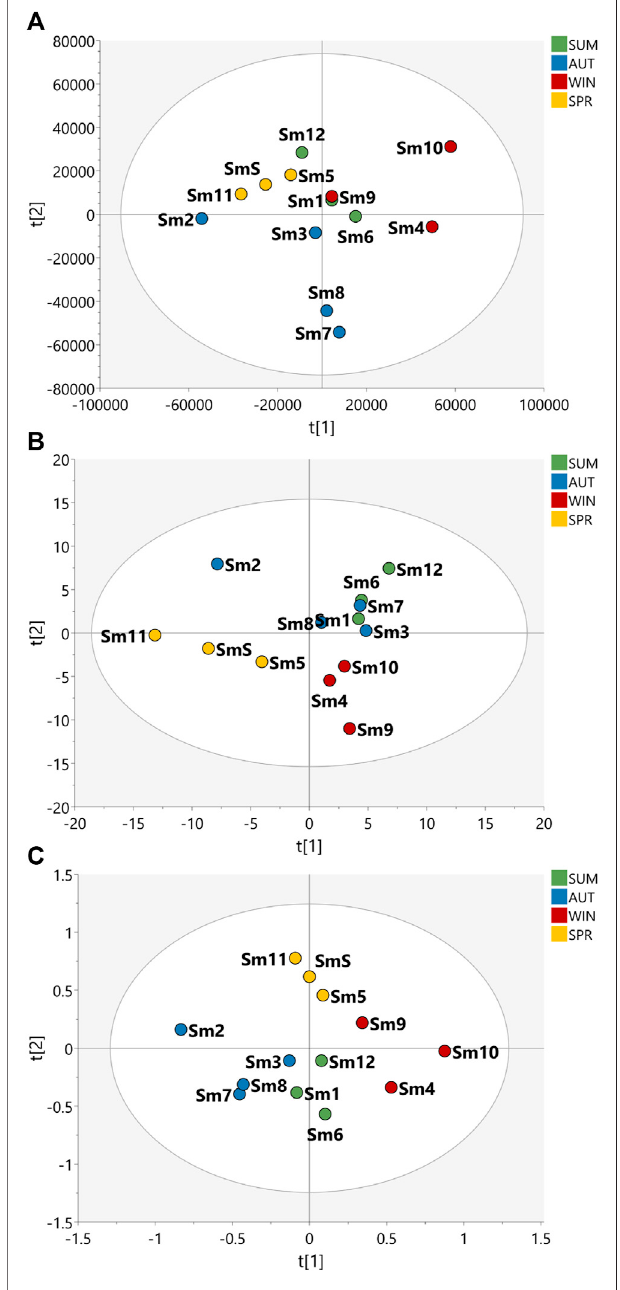
FIGURE 1 | Partial Least Squares Discriminant Analysis (PLS-DA) of the data acquired for the samples of the seasonal harvests of B. intermedia . PLS- DA score scatter plot of (A) HRMS, (B) J -res NMR and (C) MS-NMR fused data of B. intermedia extracts of summer (SUM), autumn (AUT), winter (WIN), and spring (SPR) harvests.